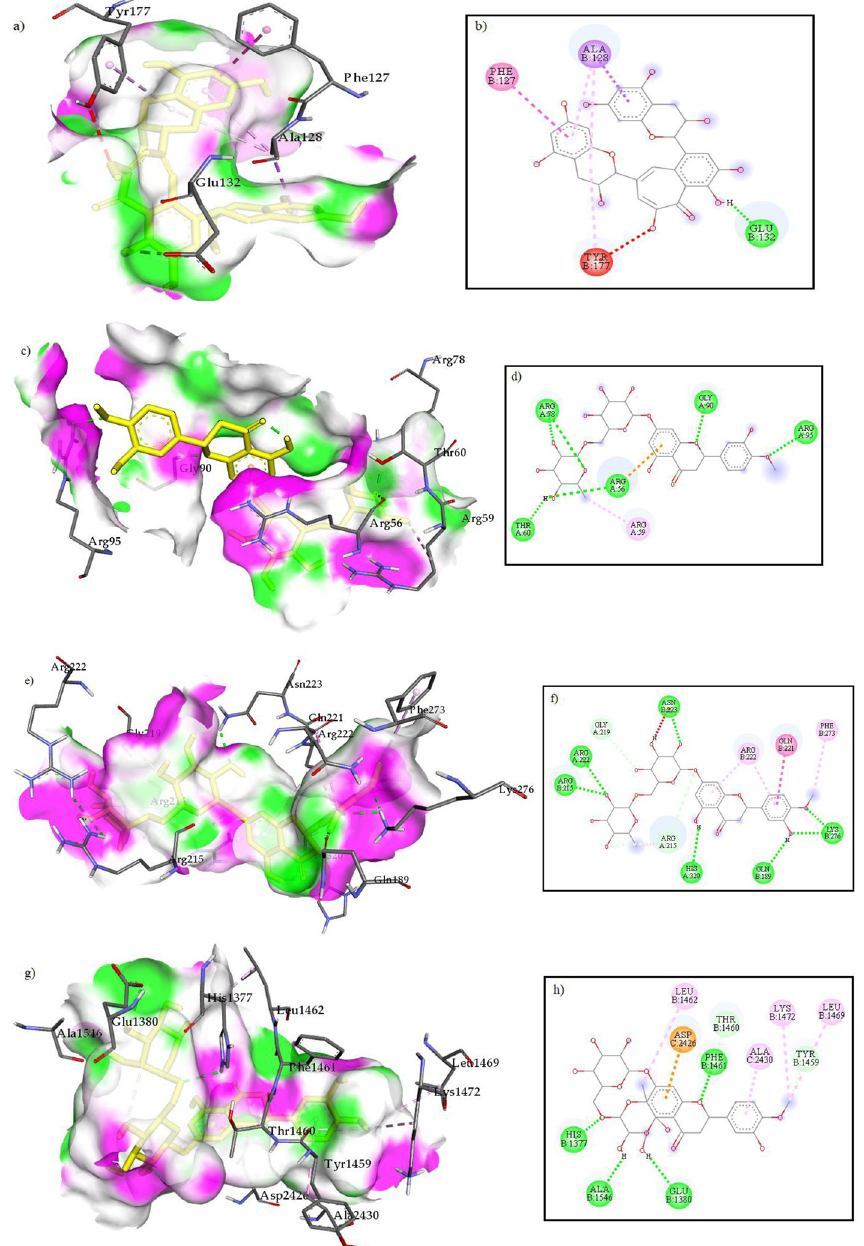
Fig 1. The 3D and 2D illustrations of the best binding mode and interacting residues of theaflavin-BCL-2 (a, b), hesperidin-BCL-W (c, d), hesperidin-MCL-1 (e, f), and hesperidin-ER α (g, h) complexes. of BCL-W protein consisting of Asp153, Arg160, Val162, Trp167, Val170, Arg171, Arg177, Ala179, and Leu180 residues [23], the interactions in the hesperidin-BCL-W complex were through two hydrogen interactions with Arg78, one hydrogen interaction with each of Arg56, Thr60, Gly90, and Arg95, one Pi-Cation interaction with Arg56, and one Alkyl interaction with Arg59 (Fig 1C and 1D). The binding site residues of MCL-1 protein were determined as His224, Ala227, Phe228, Met231, Leu235, Ile237, Leu246, Val249, Met250, Val253, Phe254,